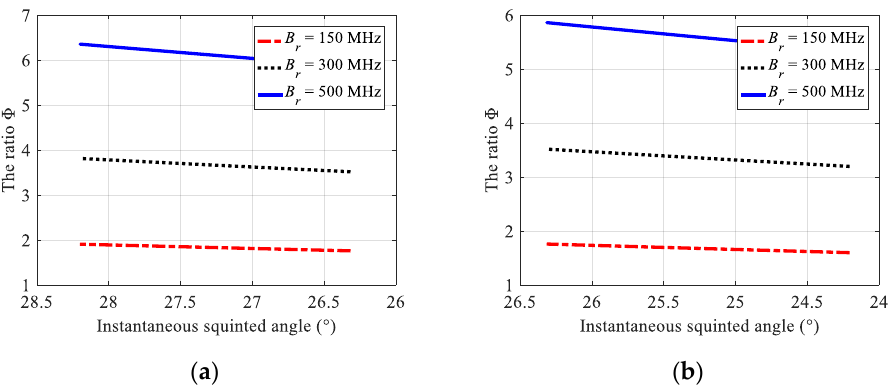
Figure 10. Ratios of the squint additional bandwidth to the azimuth beam bandwidth in adjacent